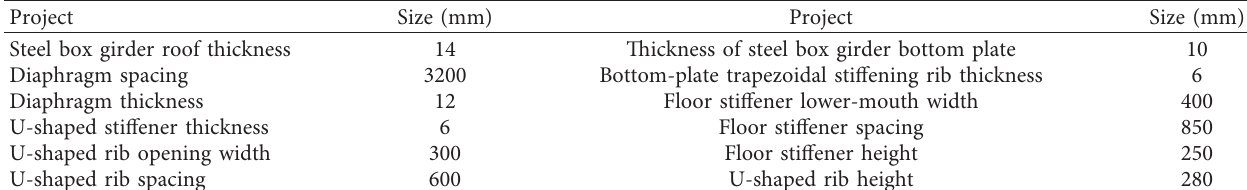
Table 2: Geometry dimensions of the subsection model.